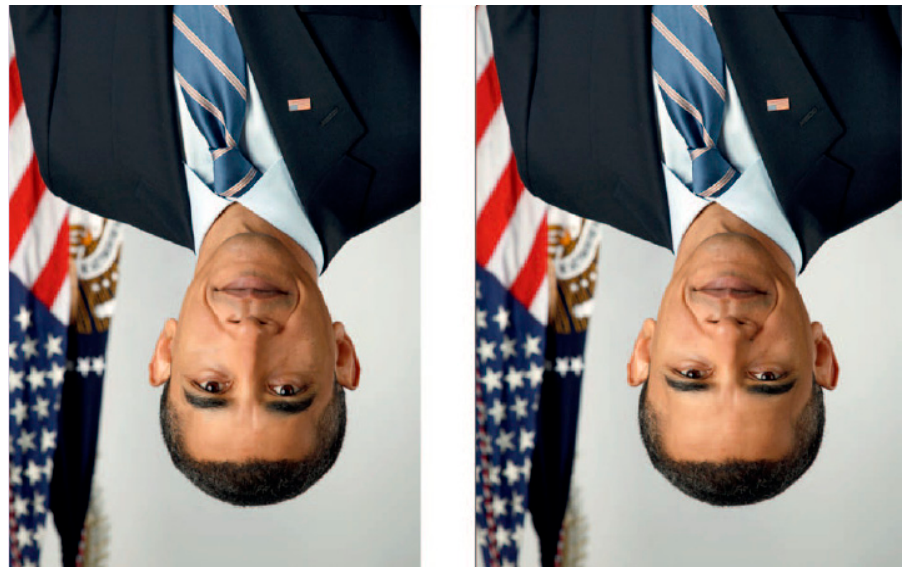
Figure 1. Holistic representation demonstrated by the face inversion effect. Look at the pictures; what you perceive is a holistic representation recalled from your memory. Turn the page upside down and look again.